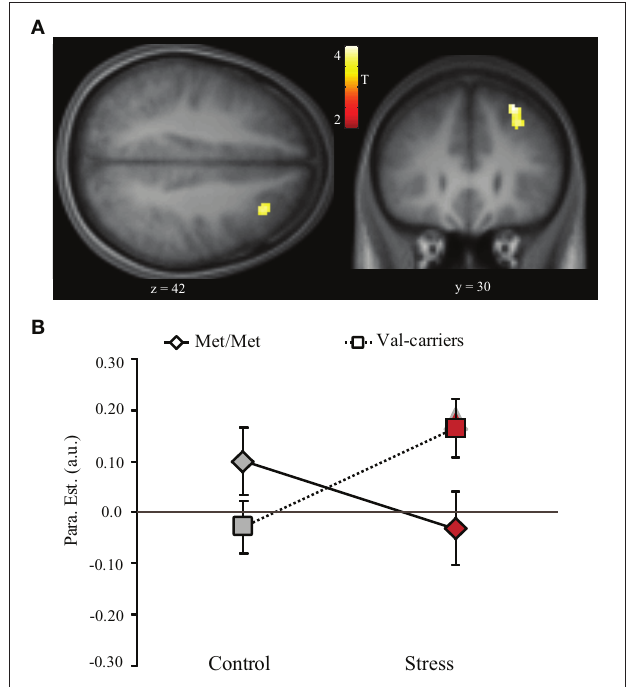
FIGURE 3 | Stress-by-COMT genotype interaction effect on WM-related activity in the dorsolateral PFC. (A) Transversal (left panel) and coronal (right panel) view of activation in the right dorsolateral PFC showing significant stress-by-COMT genotype interaction effect. Statistical parametric maps are superimposed onto spatially normalized and averaged ( n = 39) high-resolution T1-weighted images (thresholded at p < 0 . 001 uncorrected for visualization purposes). (B) Bar graphs representing parameter estimates of WM-related activation under control and stress conditions in Met-homozygotes (Met/Met) and Val-carriers. The data for these bar graphs were only extracted to illustrate the interaction effect. Note: Control, control condition; PFC, prefrontal cortex; Stress, stress condition; error bars in the graph represent standard error of mean; T, color coded t values obtained from the whole brain